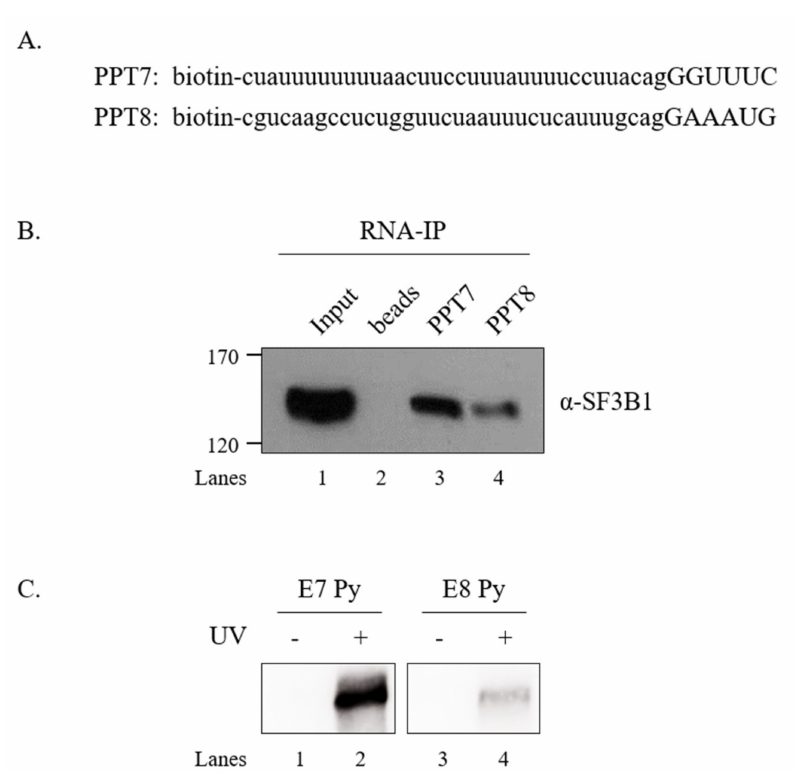
Figure 7. SF3B1 binds to PPT7 more strongly than to PPT8. ( A ) Sequences of biotin-labeled PPT7 and PPT8 oligonucleotides are shown. ( B ) RNA-IP with the anti-SF3B1 antibody using PPT7 and PPT8 oligonucleotides in HEK293T cell lysates. ( C ) UV crosslinking / IP with the anti-SF3B1 antibody using PPT7 and PPT8 oligonucleotides in HEK293T cell